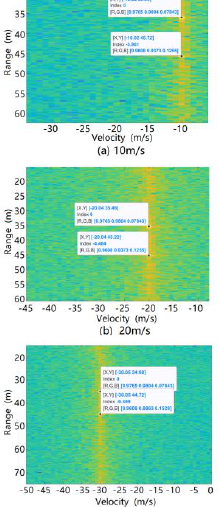
spectrum of the ground clutter was determined, as shown in Figure 17.